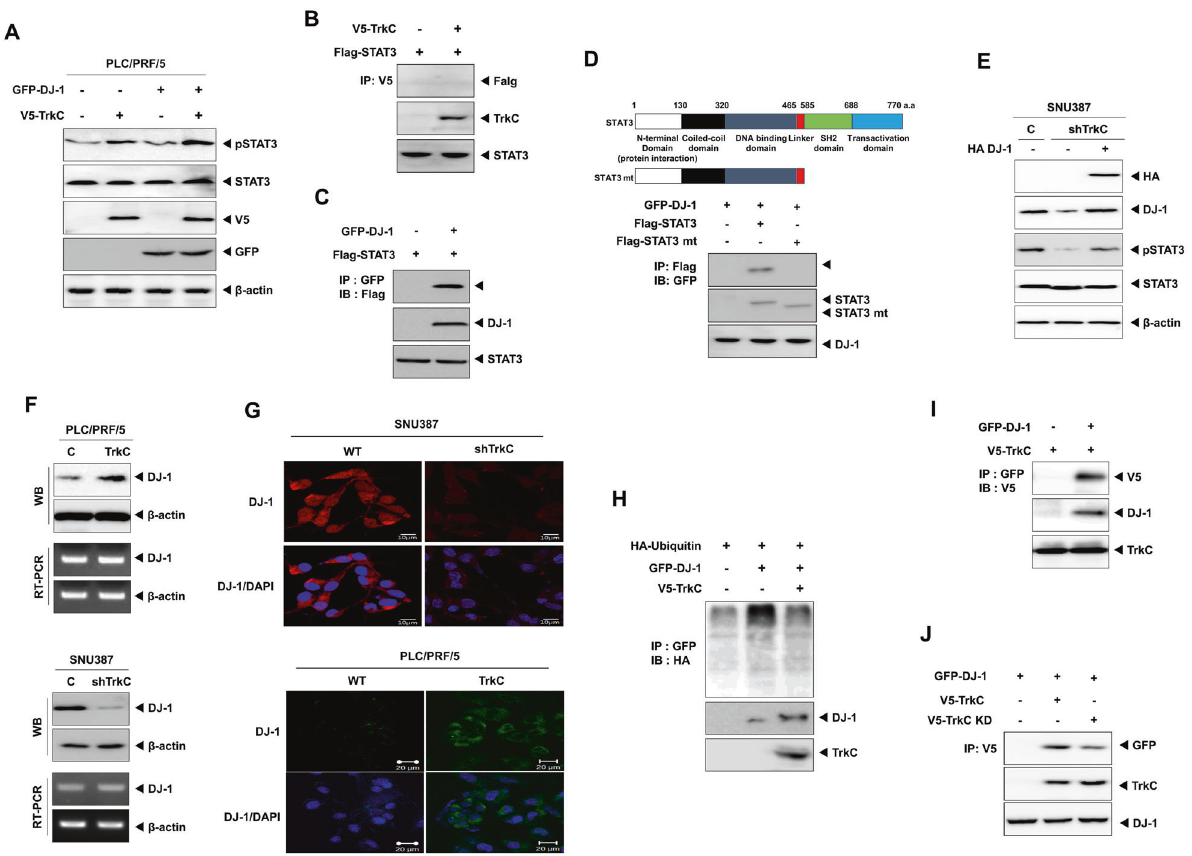
Fig. 4 TrkC activates the STAT3 pathway via inhibition of the DJ-1 degradation. A Immunoblot analysis of phospho-STAT3, STAT3, TrkC, and DJ-1 in PLC/PRF/5 after transfected with DJ-1 or TrkC. β -actin as a loading control. B Identi fi cation of complex formation of TrkC/STAT3. C Identi fi cation of complex formation of DJ-1/STAT3 by immunoprecipitation. D Identi fi cation of the STAT3 region that interacted with DJ-1. E Immunoblot analysis of phospho-STAT3, STAT3, and DJ-1 in SNU387 TrkC-shRNA cells after transfected with DJ-1. β -actin as a loading control. F Immunoblot and RT-PCR analysis of DJ-1 in PLC/PRF/5, PLC/PRF/5 TrkC, SNU387 control-shRNA, and SNU387 TrkC-shRNA cells. β -actin as a loading control. G Immuno fl uorescence analysis of DJ-1 in PLC/PRF/5, PLC/PRF/5 TrkC, SNU387 control-shRNA, and SNU387 TrkC-shRNA cells. The nuclei of cells were stained with DAPI (blue). H Immunoprecipitation analysis of 293 T cells transfected with the ubiquitin, GFP-DJ-1, and V5-TrkC constructs, as indicated. I Identi fi cation of complex formation of DJ-1/TrkC by immunoprecipitation. J Identi fi cation of the effect of the kinase activity of TrkC in the complex formation of